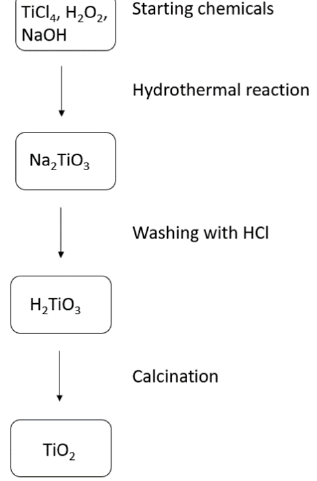
Figure 1. Scheme of TiO 2